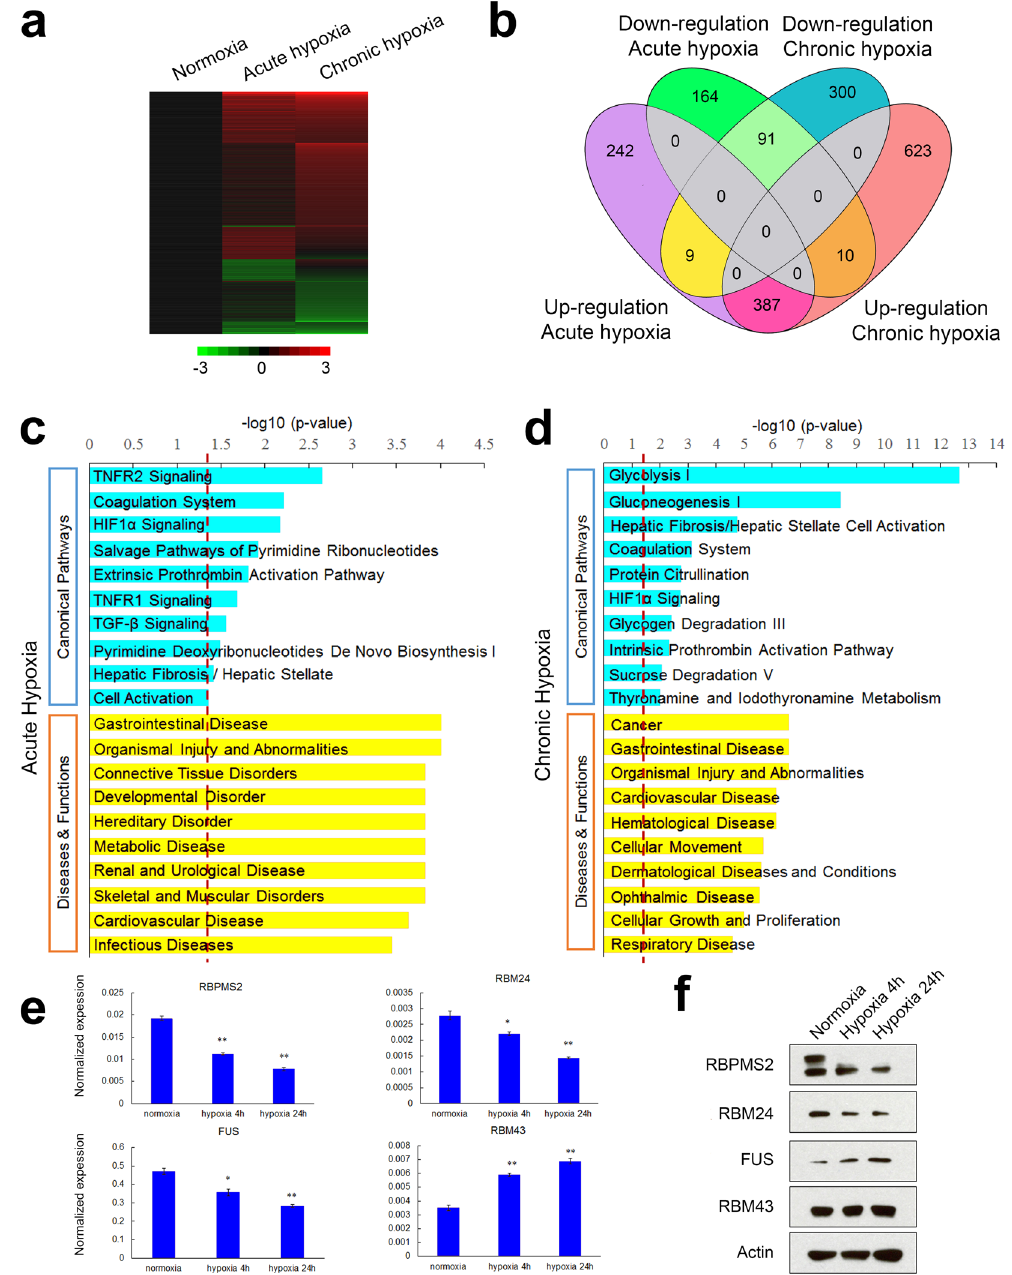
Figure 1. Hypoxia regulates gene expression in MCF7 cells. ( a ) Heat map of target genes identified from RNA-Seq of n = 1 samples that are significantly dysregulated by ≥ 1.5-fold during acute and chronic hypoxia compared to the normoxia control. Color bar shows fold difference on a Log 2 scale in red for upregulation and green for downregulation. ( b ) 4-set Venn diagram overlaps of differentially expressed genes ( ≥ 1.5-fold) during acute and chronic hypoxia that are up- or downregulated. ( c ) and ( d ) Gene ontology (GO) analysis of hypoxia regulated targets during ( c ) acute and ( d ) chronic hypoxia showing enrichments in canonical pathways as well as diseases and functions as generated by Ingenuity Pathway Analysis (IPA). Red lines indicate p-value of 0.05 for Fisher’s exact test. ( e ) Real-time qPCR analysis of the mRNA expression of the splicing factors RBPMS2, RBM24, FUS and RBM43 in normoxia, acute and chronic hypoxia. The expression of the housekeeping reference gene PPIA was used as a control. All qRT-PCR analysis was performed in three biological replicates (n = 3). Error bars indicate SEM. Statistical significance was evaluated with Student’s t-test. * indicates p-value < 0.05, ** indicates p-value < 0.01. ( f ) Western blot analysis of the protein expression of the splicing factors RBPMS2, RBM24, FUS and RBM43 in normoxia, acute and chronic hypoxia. Actin was used as a loading